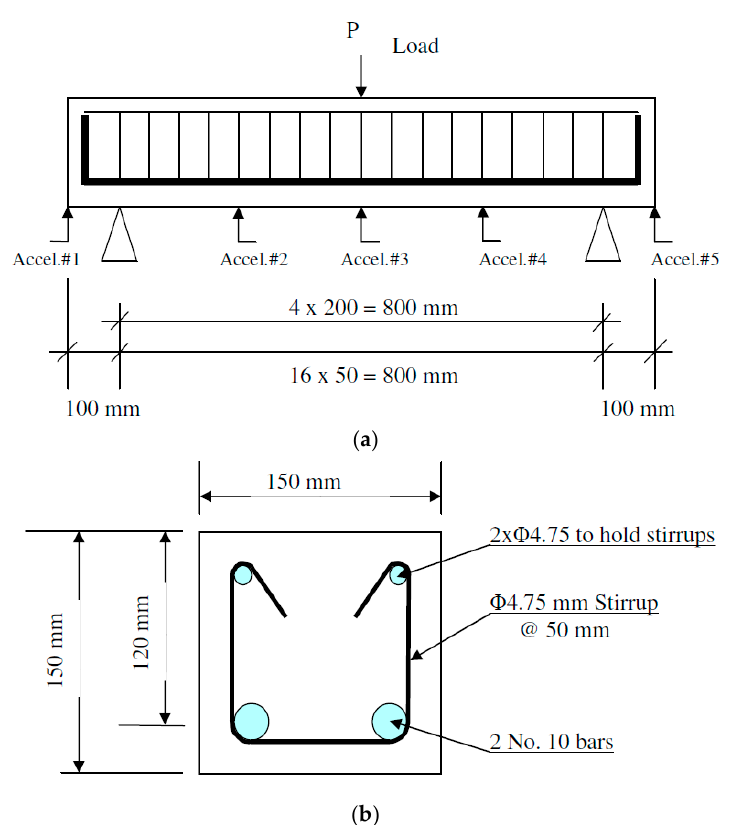
Figure 4. Elevation and cross-section of RC beams tested under impact loading; ( a ) elevation; ( b ) cross-section [22].